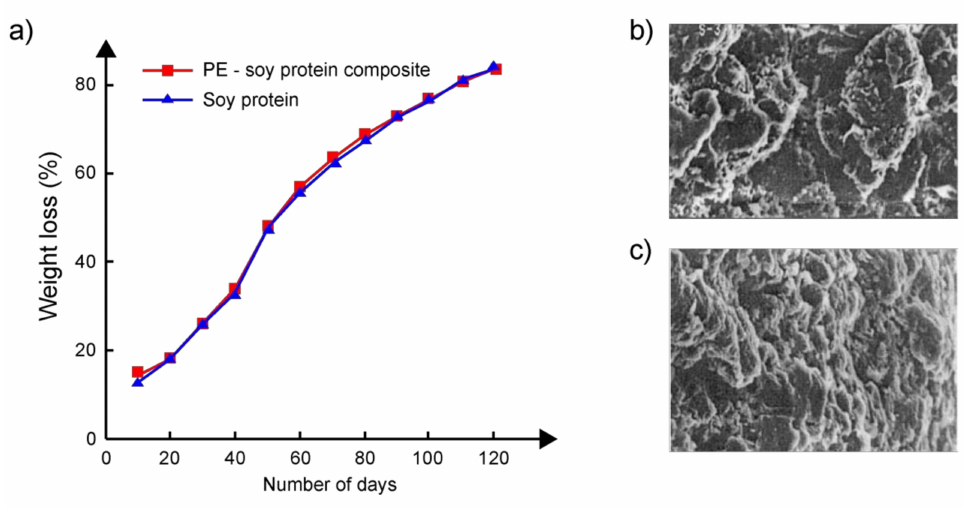
Figure 6. ( a ) Percentage weight loss of soy protein and PE/soy protein composite as a function of residence time in soil. SEM micrographs of a sample of the PE/soy protein composite ( b ) before and ( c ) after biodegradation in soil (magnification 2000 × ). Adapted from Inderjeet Kaur et al.